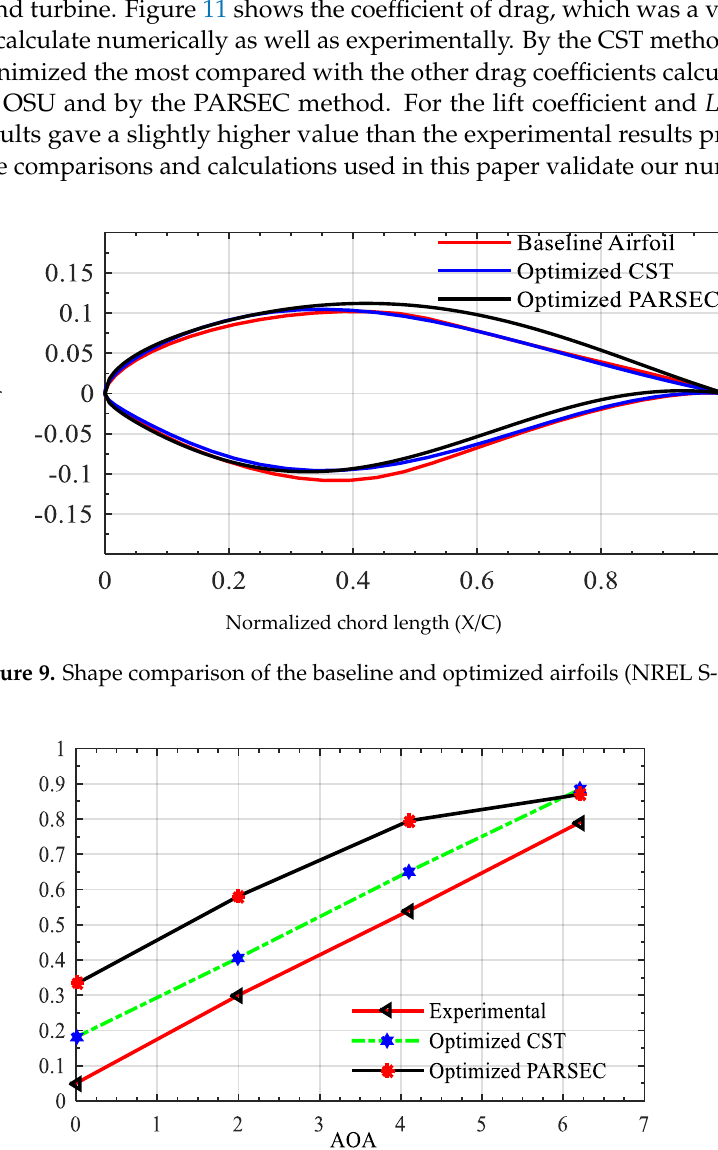
18 of 26 Table 6. Performance comparison of the original and optimized airfoils (NREL S-809). NREL S-809 Relative Variation Experimental Data (OSU)